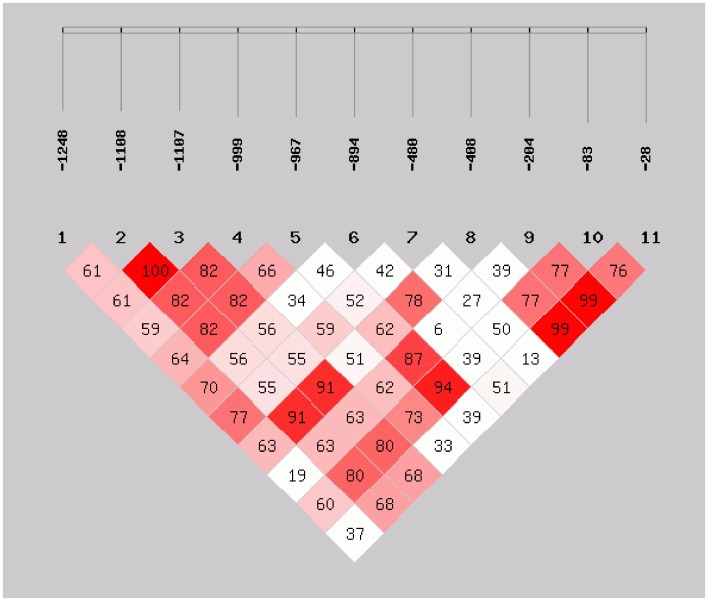
The linkage disequilibrium analysis of the 11 SNPs in the promoter region of AiHSP70. SHEsis software (http://analysis2.bio-x.cn/myAnalysis.php) was used for this analysis. The colour scheme is: white (D = 0), pink (0<D<1), red (D = 1).